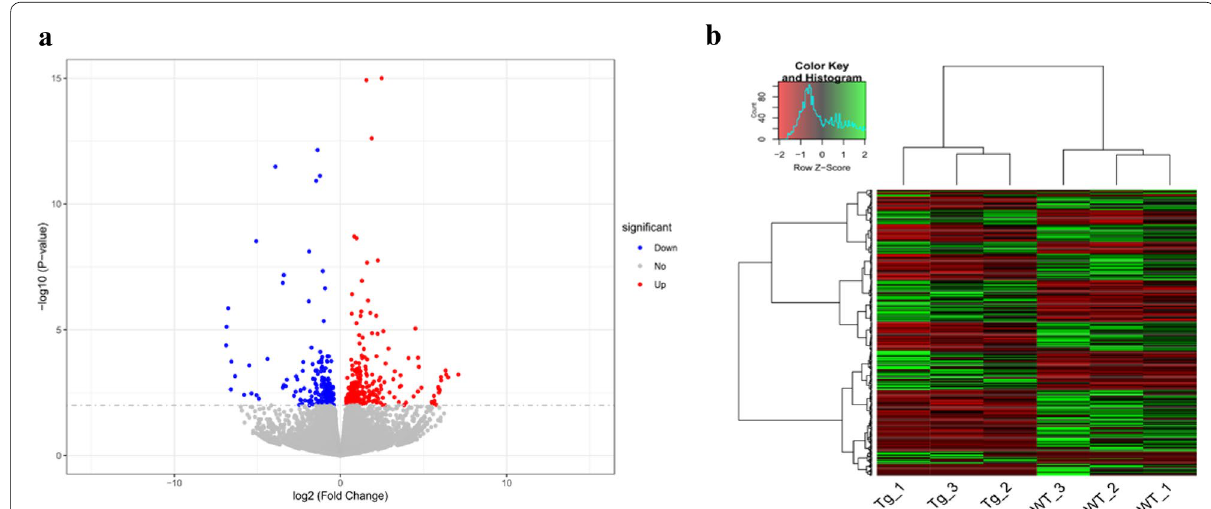
Fig. 3 Analysis of differentially expressed genes. a Volcano plot for screening DEGs ( p < 0.01). b Hierarchical cluster analysis of DEGs ( p < 0.01)